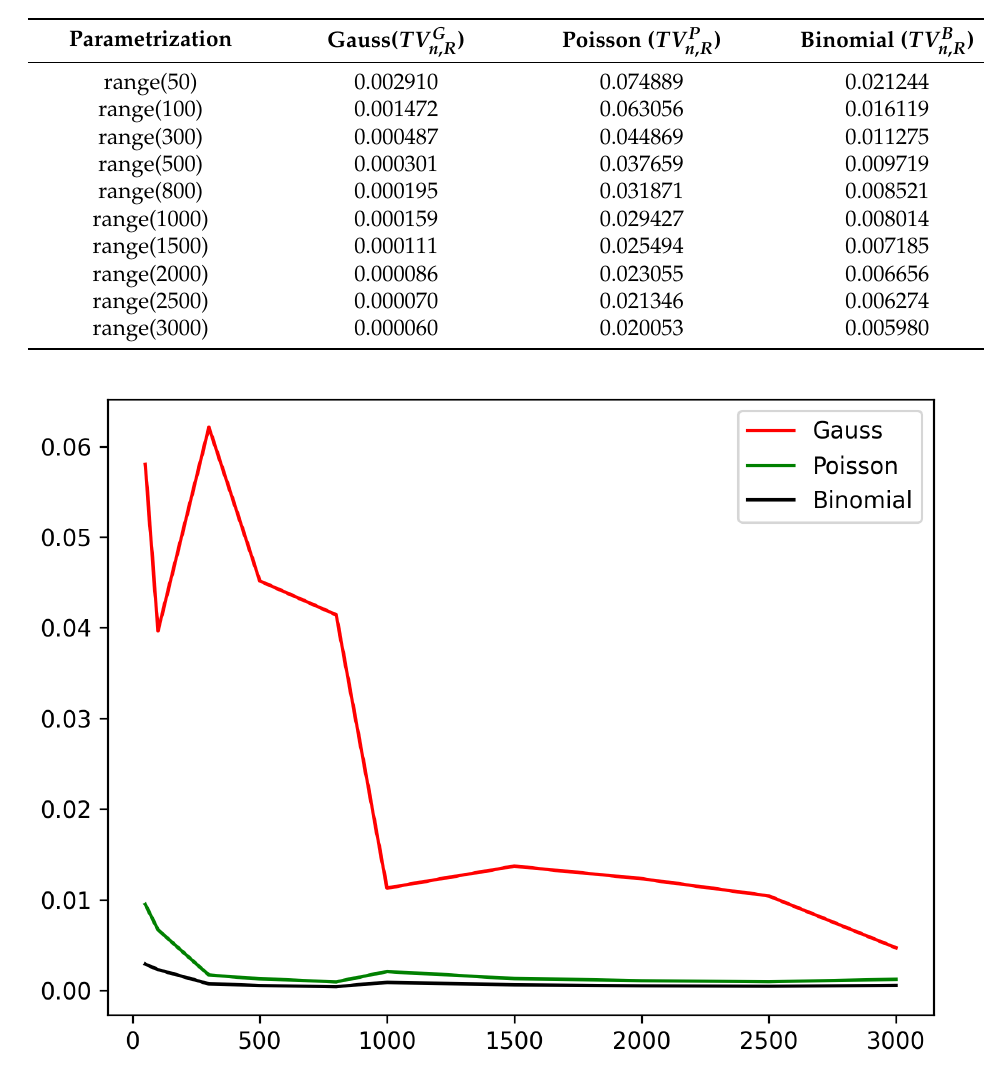
Table 3. Total variational distance between the approximated and the exact degree distributions when the IRG is created using Range parametrization.